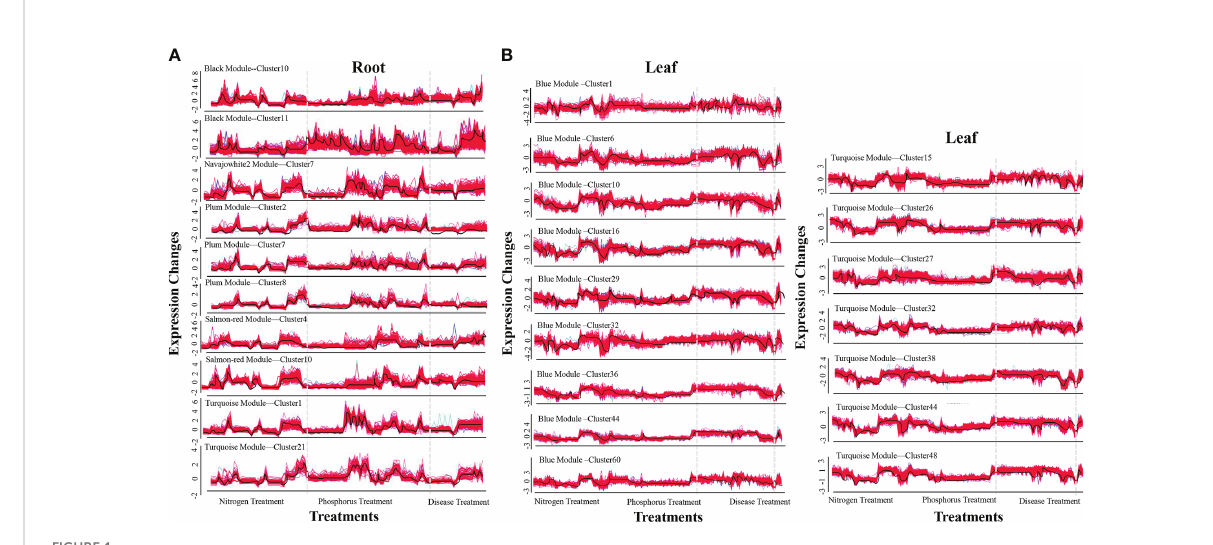
FIGURE 1 The most effective clusters of co-expression modules in roots and leaves. (A) Optimal root clusters. (B) Optimal leaf clusters. The ordinate represents the fold changes in expression. The abscissa represents different processing treatments. The black curves in the fi gure re fl ect a change in